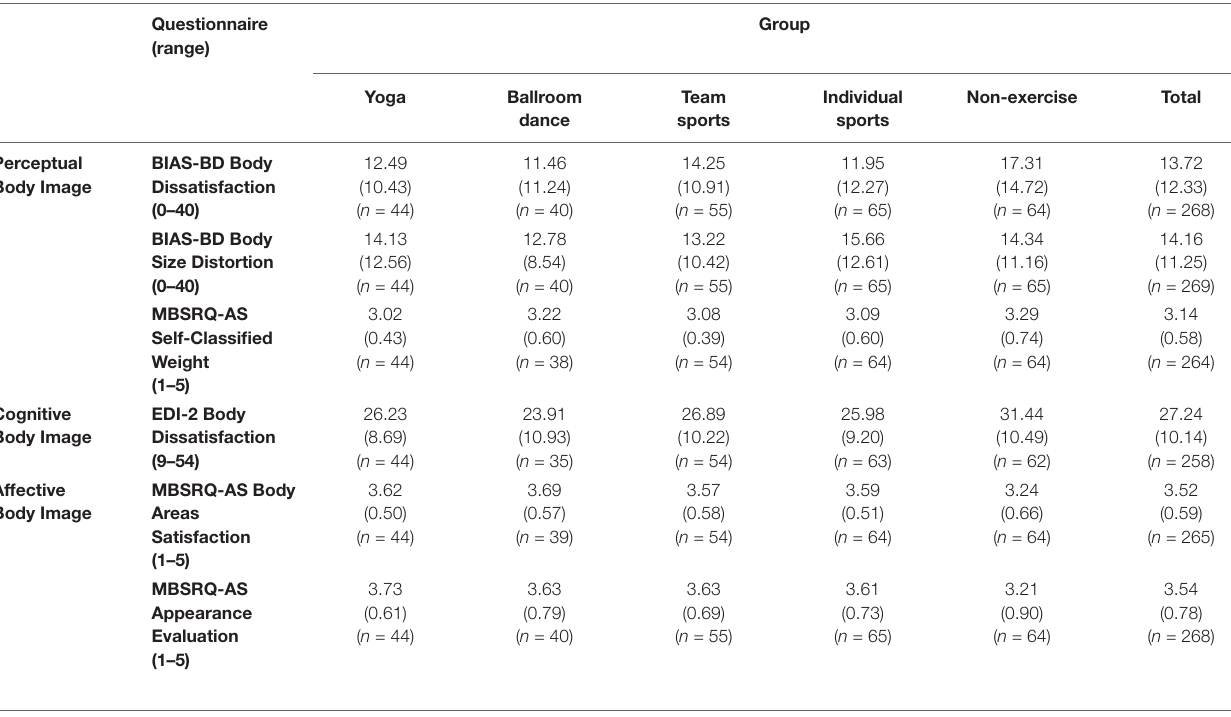
TABLE 2 | Descriptive statistics: Mean scores, standard deviations (SDs in brackets) and group size ( n ) of body image questionnaires in dependence of group. Questionnaire